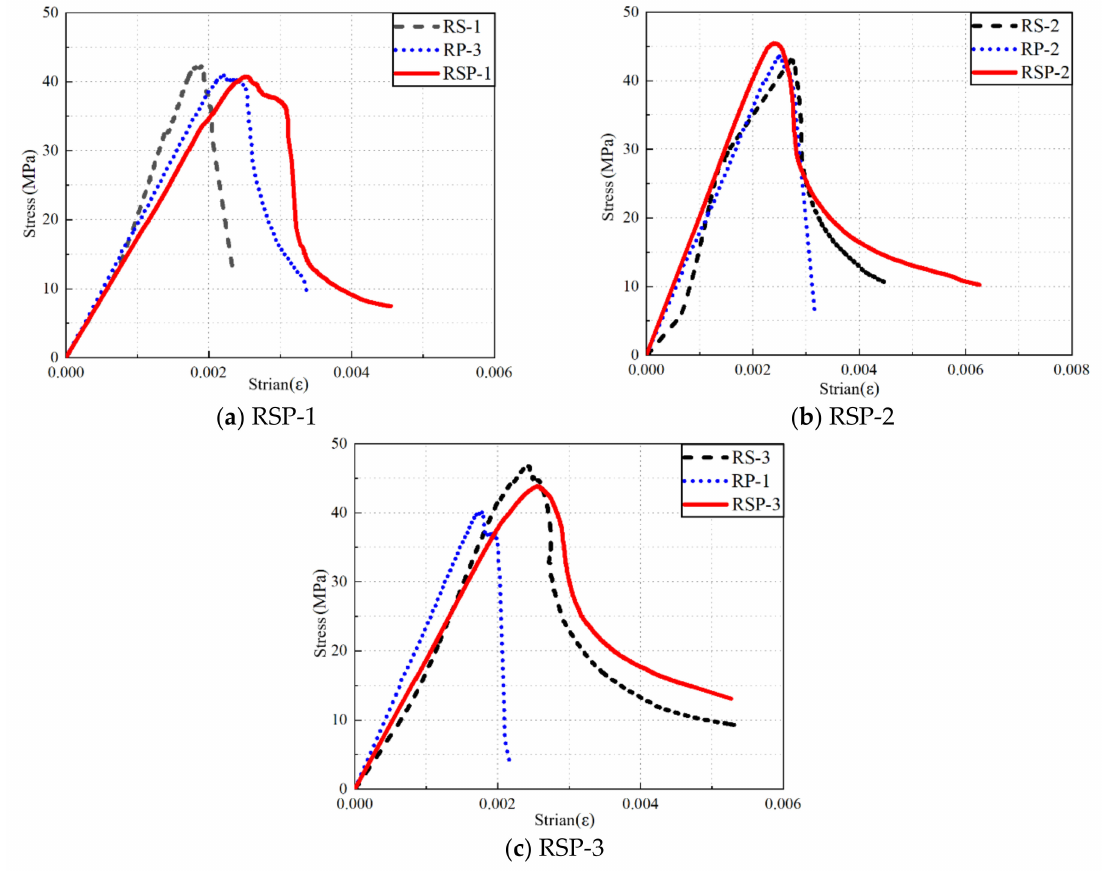
Figure 14. Uniaxial compressive stress–strain curve of single and hybrid recycled